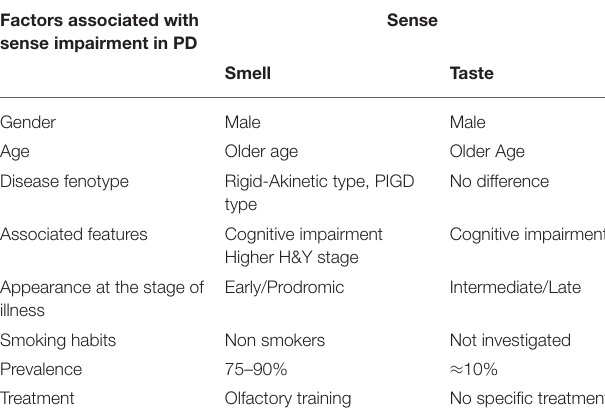
TABLE 1 | Summarizes the main PD clinical and demographic features associated with smell and taste impairment. Factors associated with sense impairment in